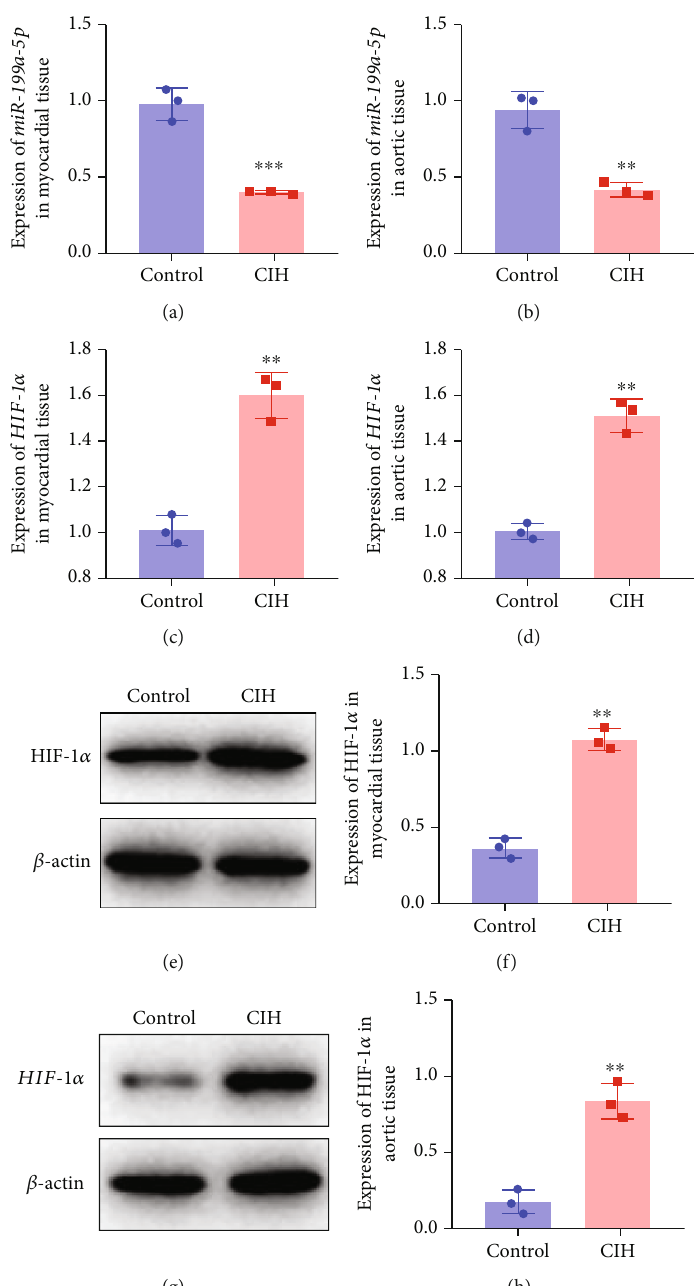
Figure 1: miR-199a-5p and HIF-1 α expression in the animal model of OSAS with hypertension. mRNA expression of miR-199a-5p in (a) myocardial tissue and (b) aortic tissue by qRT-PCR. mRNA expression of HIF-1 α in (c) myocardial tissue and (d) aortic tissue by qRT-PCR. Protein expression of HIF-1 α and quanti fi cation in (e, f) myocardial tissue and (g, h) aortic tissue by western blot. CIH: chronic intermittent hypoxia. ∗∗ P < 0 : 01 , ∗∗∗ P < 0 : 001